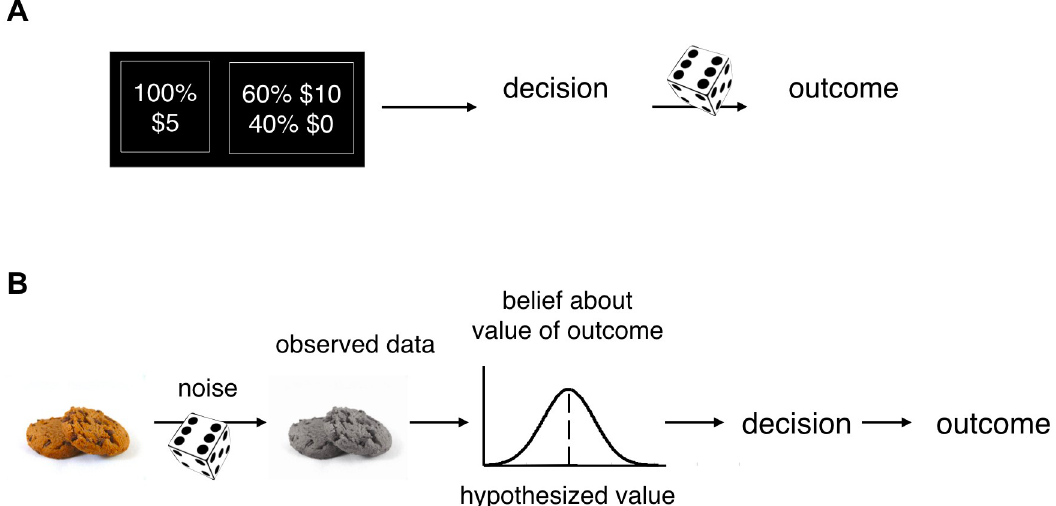
Fig 1. Types of uncertainty in risky choice. (A) In lotteries, uncertainty arises due to stochasticity in the mapping from decision to outcome. This is a form of aleatoric uncertainty. (B) Uncertainty can also arise from information about a choice item being incomplete or imperfect. In a probabilistic framework, the result of inferring the unknown value of a future outcome is captured by a posterior distribution, the width of which is a measure of uncertainty. This is a form of epistemic uncertainty.